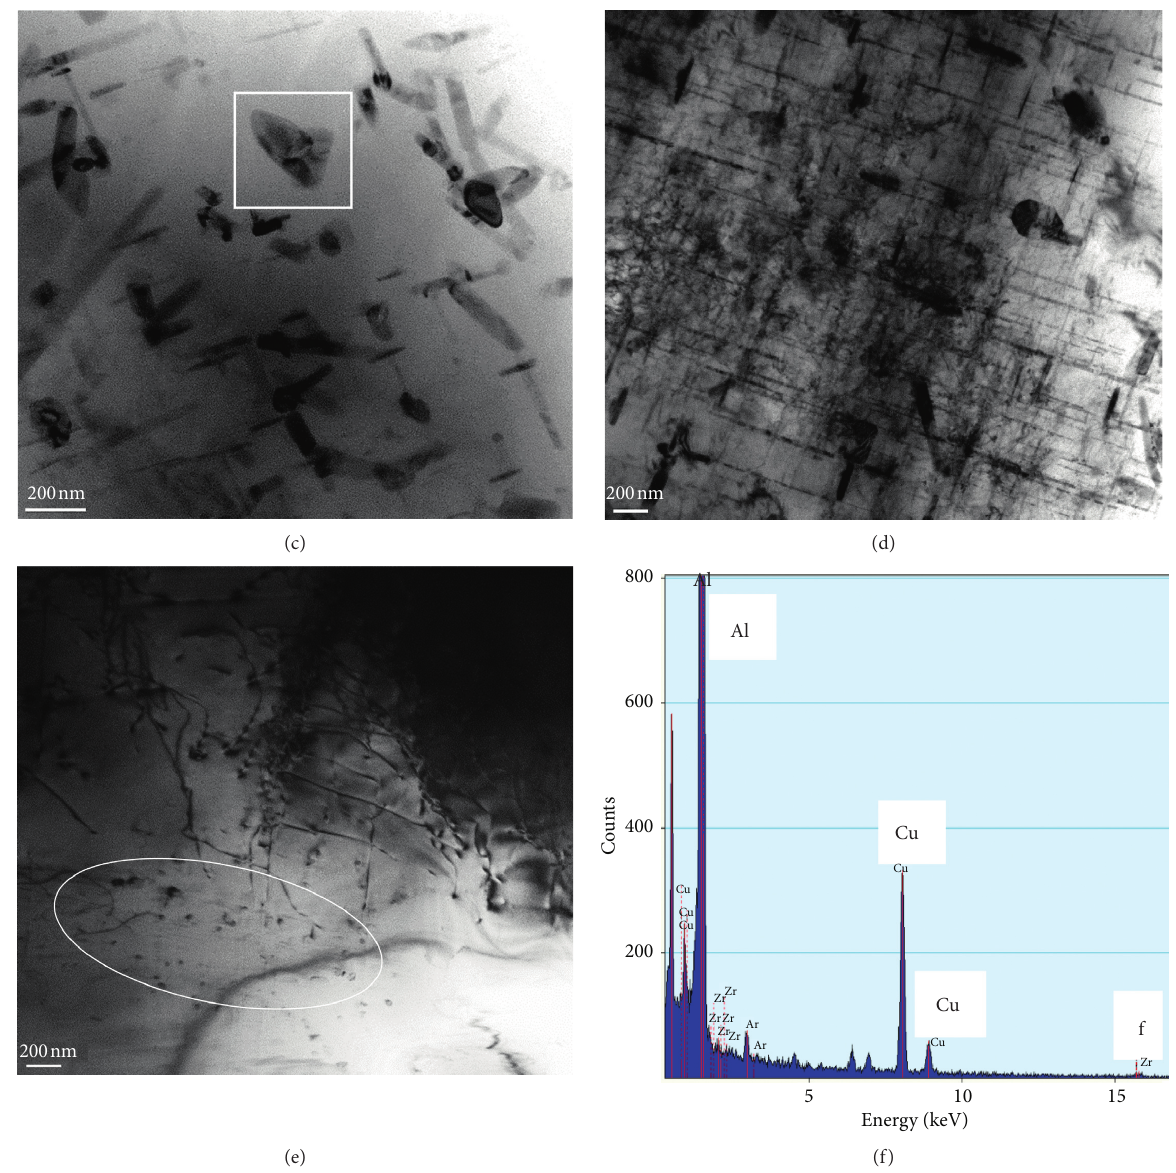
Figure 8: Bright field electron micrographs showing the progress in the size and distribution of the precipitated second phase during aging at 190oC. (a) 2h, (b) 200h, (c) 1000h, (d) dislocation/particle imteractions in condition (c), note the high dislocation density, (e) dislocation density in alloy A after solutionizing treatment, note the size of the preciptated particles in the white area, and (f) EDS spectrum cor- responding to square area in (c) revealing Al and Cu peaks. Table 3: Tensile properties of alloy A in the as-cast condition.